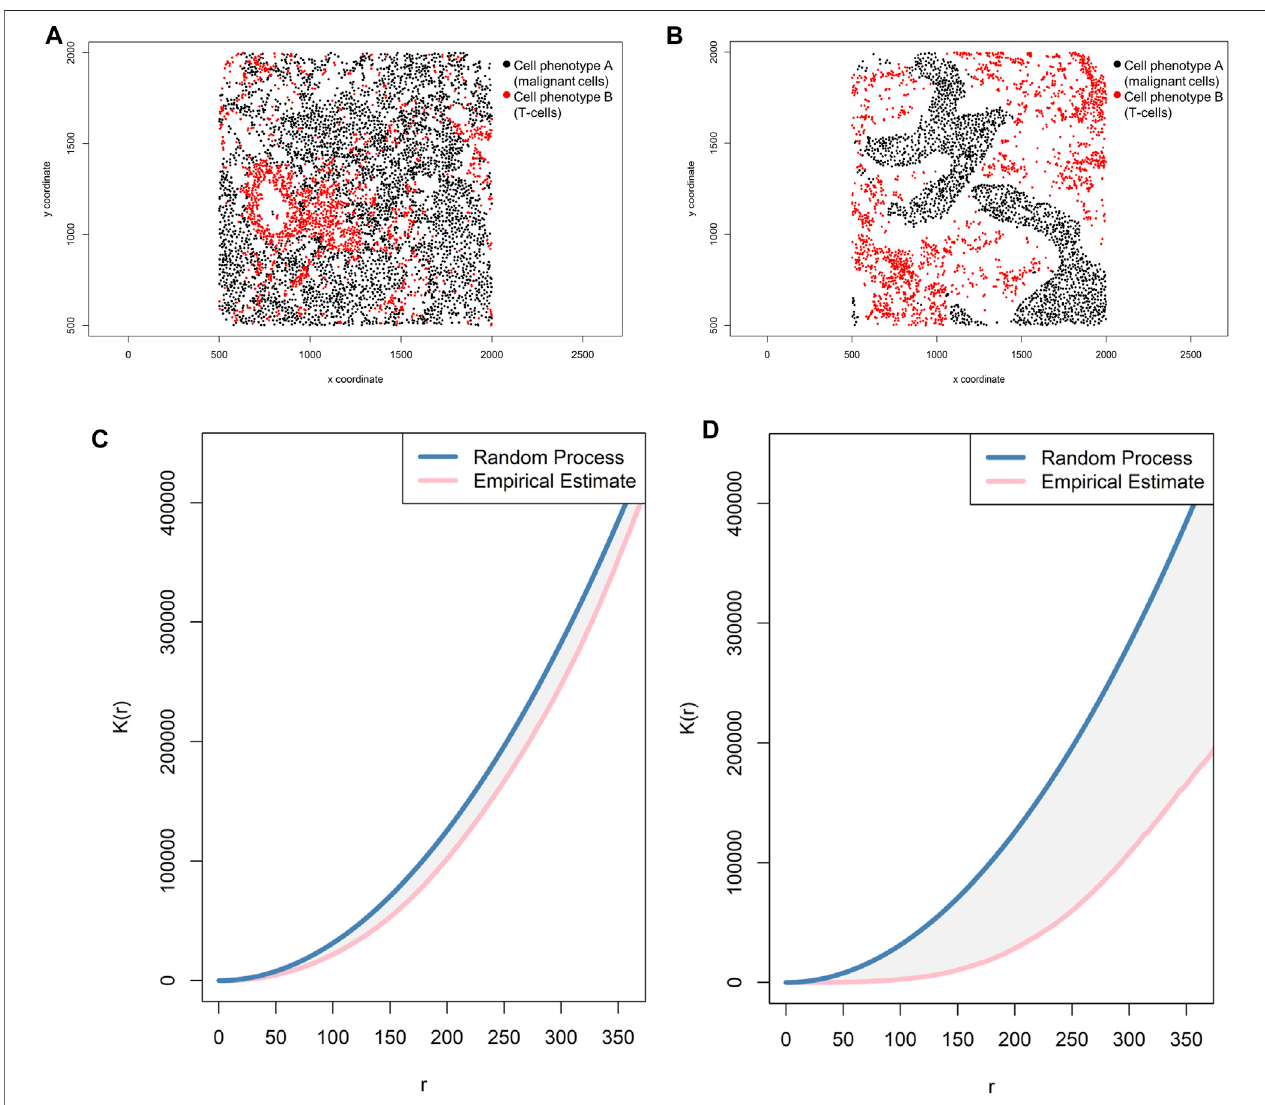
FIGURE 10 | Representative graphs showing the K-function [K( r )] curve of cellular distributions between two groups of cells from a representative point pattern of multipleximmuno fl uorescenceimagesoflungadenocarcinoma. (A) RandompointpatterndistributionofcellphenotypeAandB. (C) K( r )curveextractedfromtheimage shown in A, showing the proximity of the curve to the theoretical estimate curve (Poisson curve), characterizing a random or mixed distribution pattern of the two cell phenotypes. (B) Unmixed point pattern distribution ofcell phenotype A and B. (D) K( r ) curve extractedfrom theimage shown in B, showing the increaseddistance of thecurve from the theoretical estimate curve(Poisson curve), characterizing aclustering or unmixed distribution pattern ofcell phenotype Aand B. Thegraphics were generated using R studio software version 3.6.1.